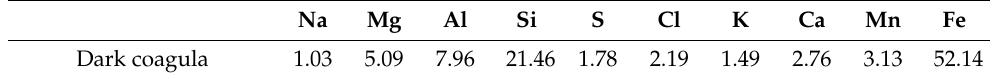
Table 3. EDXRF analysis results of the dark coagula on the outer surface of sample DL-1.